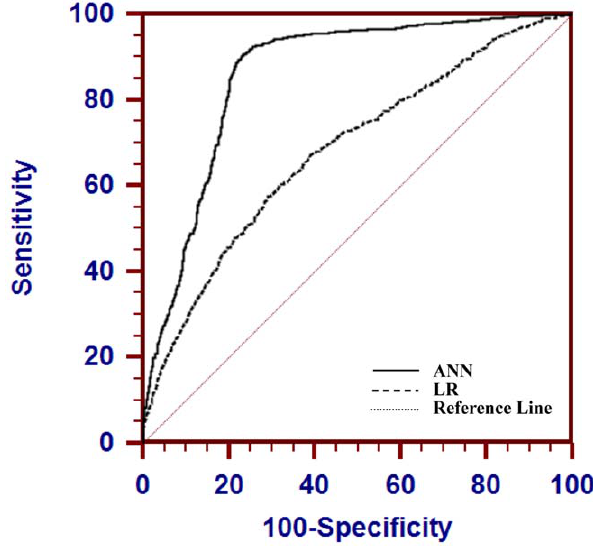
Figure 2. ROC curves of ANN and LR prediction models in the validation group. Areas under ROC curves were 0.86 and 0.68 for ANN and LR models, respectively. Area under ROC curve obtained by ANN was superior to that obtained by LR. Abbreviation: ANN, artificial neural network; LR, logistic regression; ROC, receiver operating characteristic.